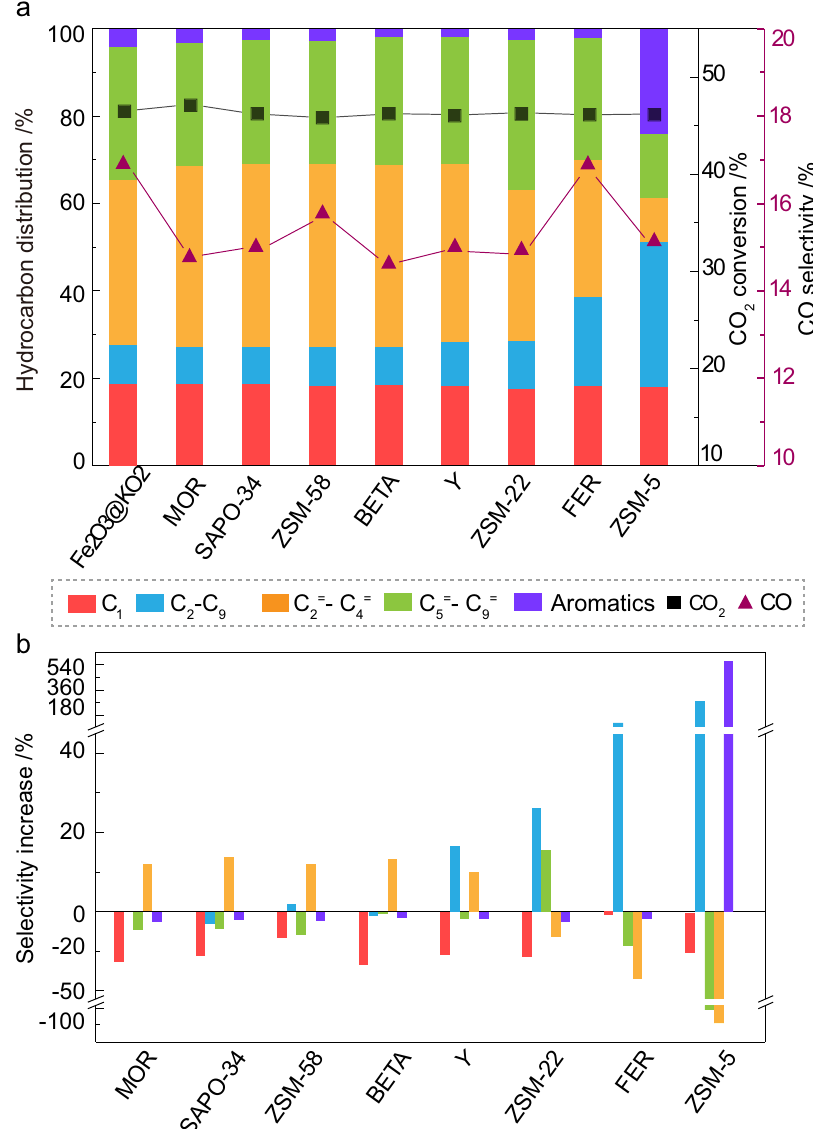
Fig. 2 Catalytic performance of the Fe 2 O 3 @KO 2 /zeolite bifunctional material catalyzed hydrogenation of CO 2 process. a Comparison of catalytic data using different zeolites. b Detailed illustration of the (net) selectivity increase (or decrease) of individual hydrocarbon groups upon introducing zeolites with respect to the standalone Fe/K catalyst. Reaction condition: 30 bar, 375 °C, H 2 /CO 2 = 3, and 10,000mL · g − 1 · h − 1 at a time on stream of 48